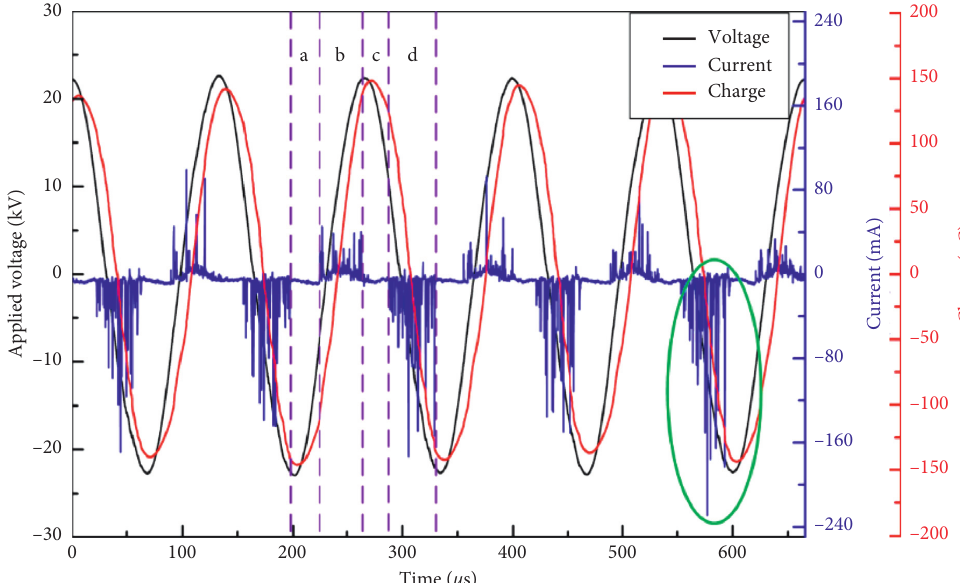
Figure 3: Typical voltage, current, and charge waveforms of the coaxial